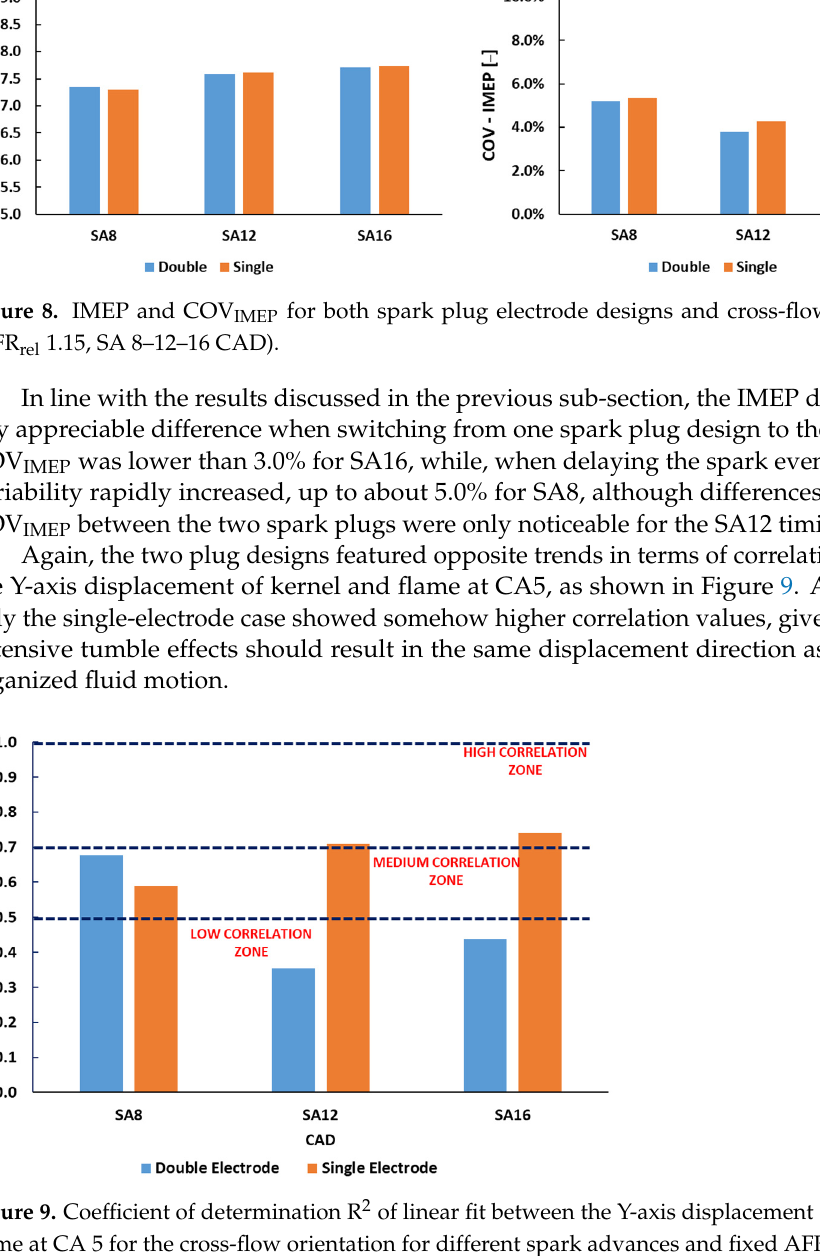
Figure 10. Evolution of the coefficient of determination R 2 of the linear fit between kernel position and flame displacement at CA5 during the early stages of combustion during the early stages of the combustion process for the cross ‐ flow orientation at fixed SA (16 CAD) and AFR rel (1.15). 5.3. Uni ‐ Flow and Counter ‐ Flow Orientations Further investigations were performed by considering the spark plug orientation parallel to the tumble motion corresponding to uni ‐ and counter ‐ flow for the single ‐ elec ‐ trode and uni ‐ flow for the double ‐ electrode. Looking at Figure 11b, no significant differ ‐ ences were found in terms of IMEP or its COV when changing spark plug orientation. More noticeable changes were recorded for peak pressure (Figure 11a) when comparing the counter ‐ flow condition with double uni ‐ /counter ‐ flow and single uni ‐ flow configura ‐ tions. In more detail, the former featured lower peak pressure values for each investigated air–fuel ratio (an overall decrease of 1.5–1.8 bar was noted).